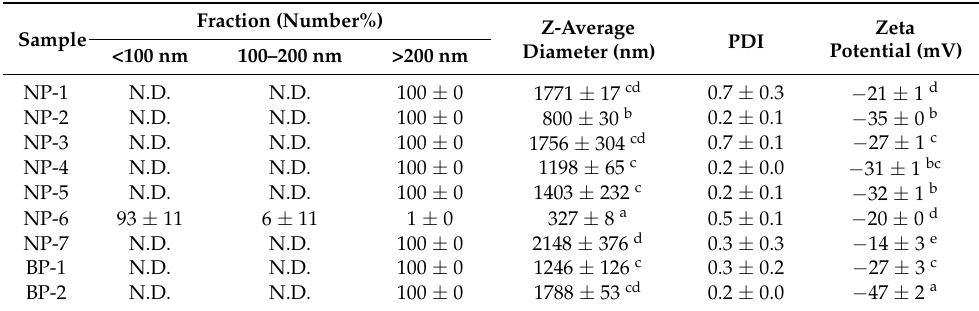
Table 4. Particle fractions, hydrodynamic diameters, and surface charges of TD-NPs and conventional BPs at 25 ◦ C 1